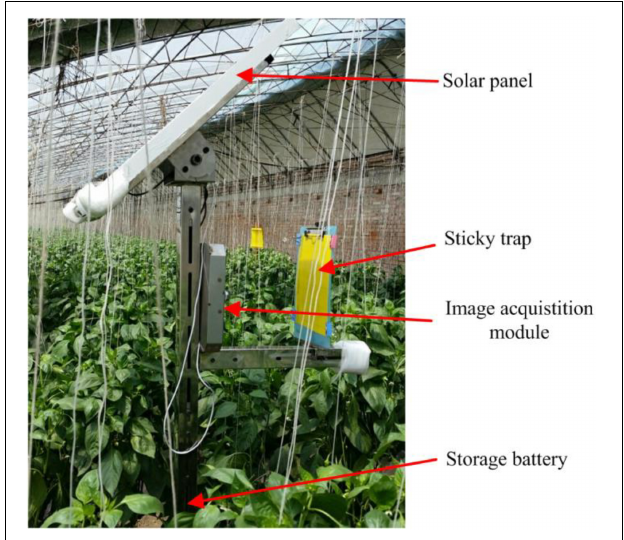
FIGURE 1 | Image acquisition equipment and sticky trap for detection of insect pests in greenhouse conditions (Li et al.,